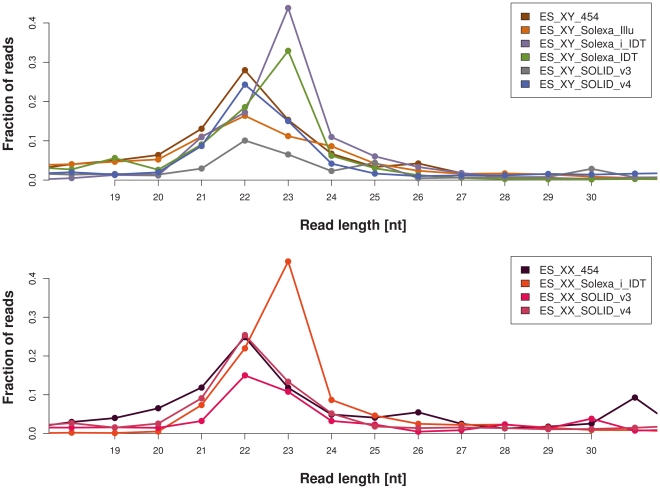
Read length distributions after adapter removal.The upper panel shows the E14 XY libraries while the lower panel displays the PGK XX libraries. See Table 1 for details about the libraries.